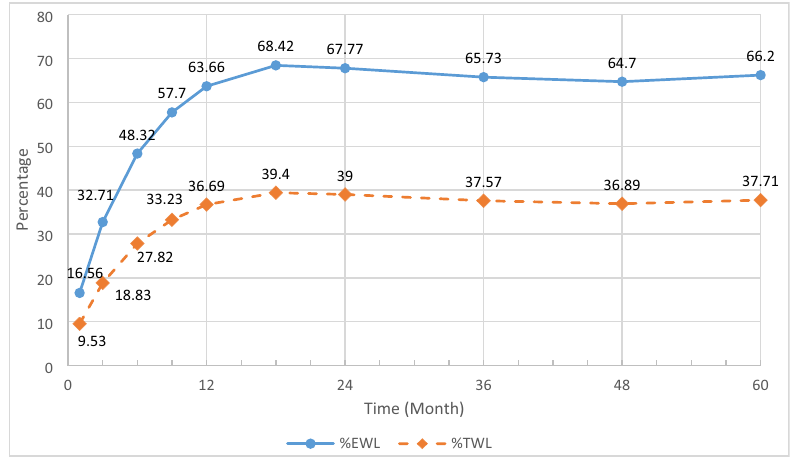
Figure 1. Percent excess weight loss (%EWL) and percent of total weight loss (%TWL) trend in patients with BMI ≥ 50 kg/m 2 undergoing OAGB.